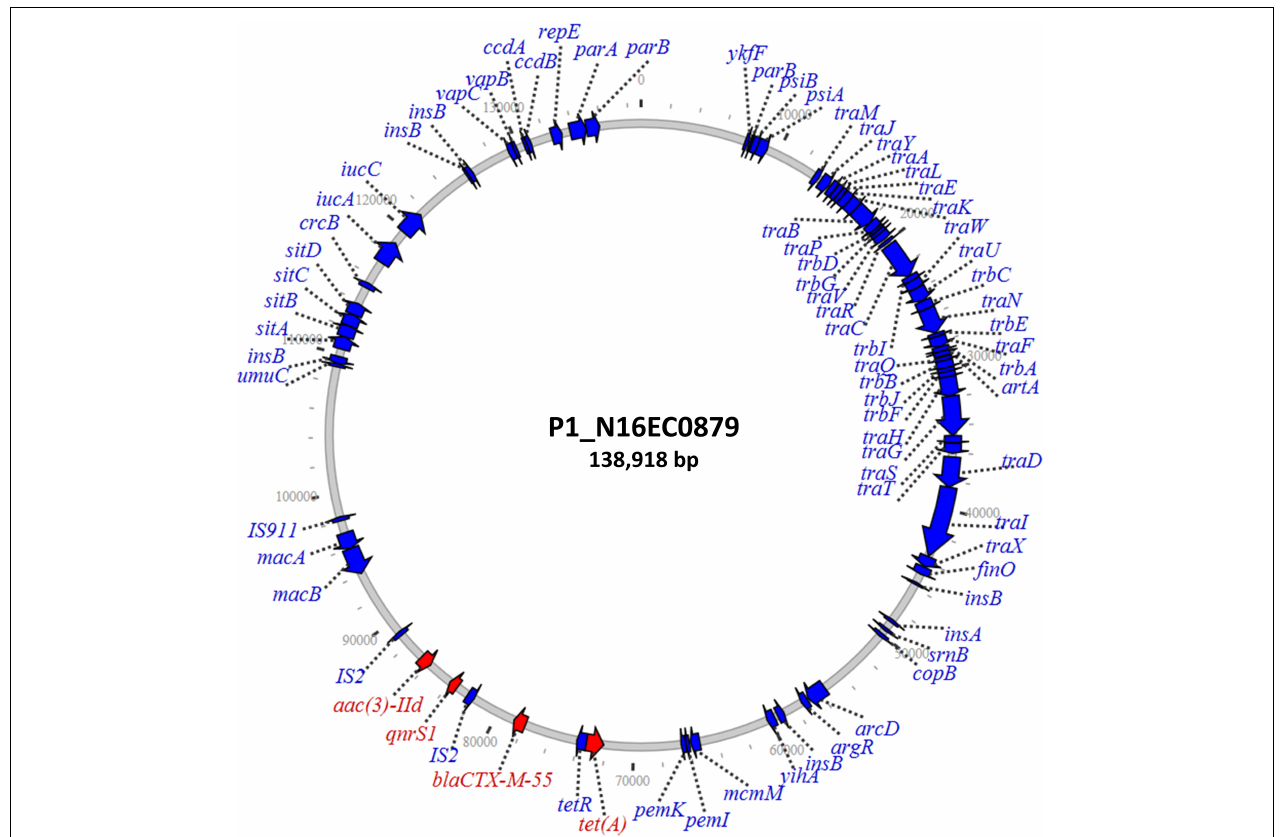
FIGURE 3 | Large IncF plasmid containing qnrS1 along with various additional resistance